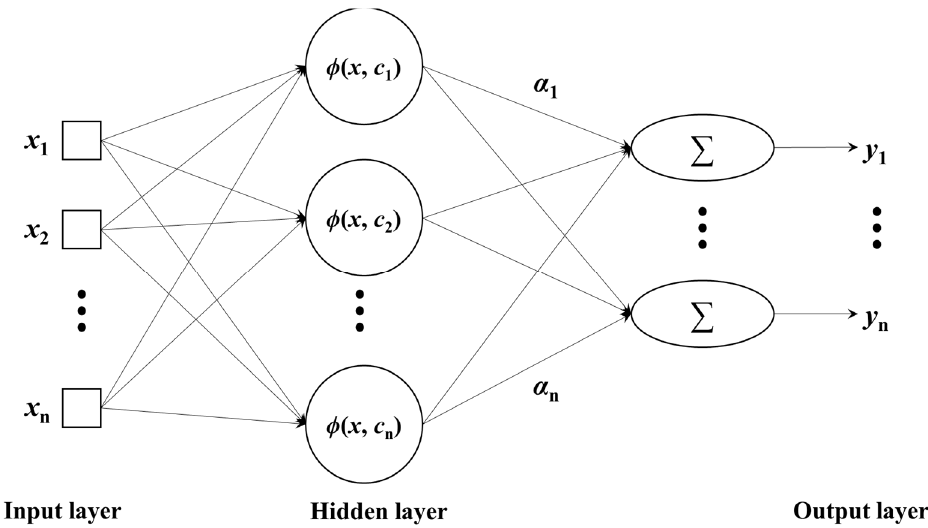
Figure 8. The architecture of a radial basis function network.